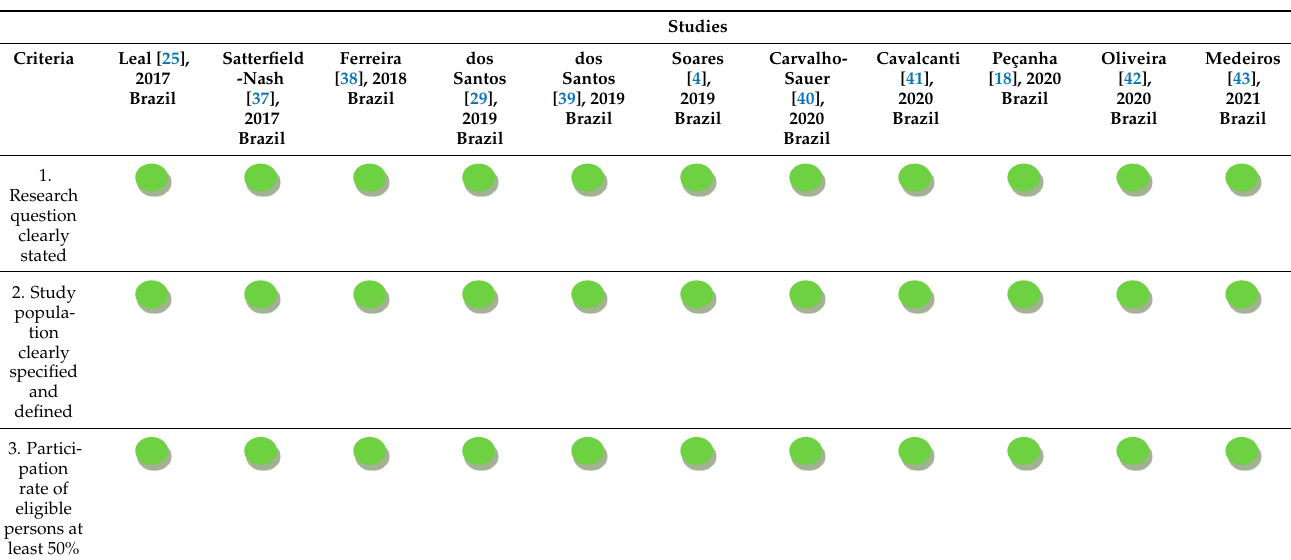
Table 1. Methodological quality and risk of bias of included articles.